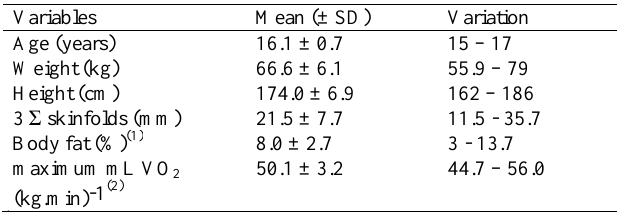
Table 1. Physical characteristics and metabolic parameters of the